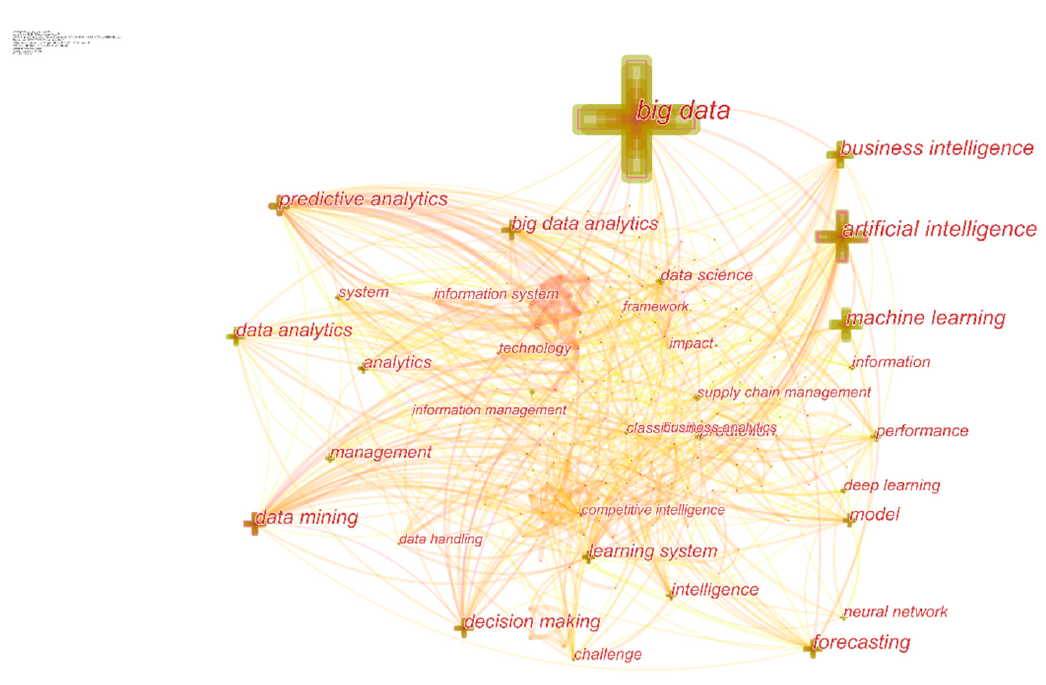
Figure 8. The distribution of keywords (The cross pattern represents the keyword). Table 7. Top 10 keywords ranking according to the number of publications